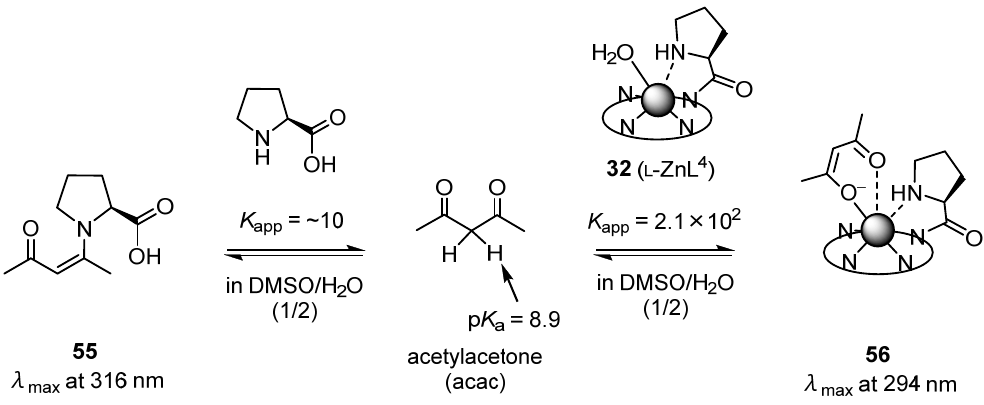
Table 5. The apparent enaminone or Zn 2+ -enolate formation constants ( K